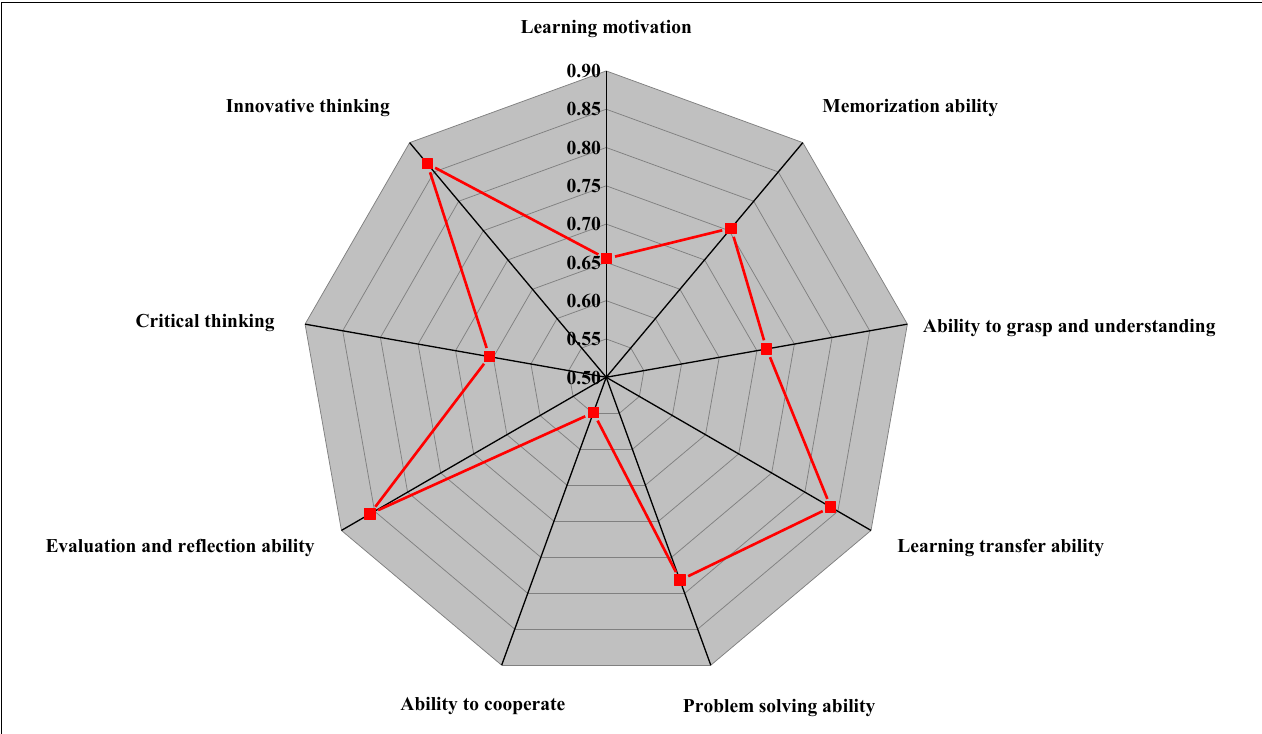
FIGURE 8 | Cronbach’s α coefficient of each dimension in the questionnaire survey (QS).